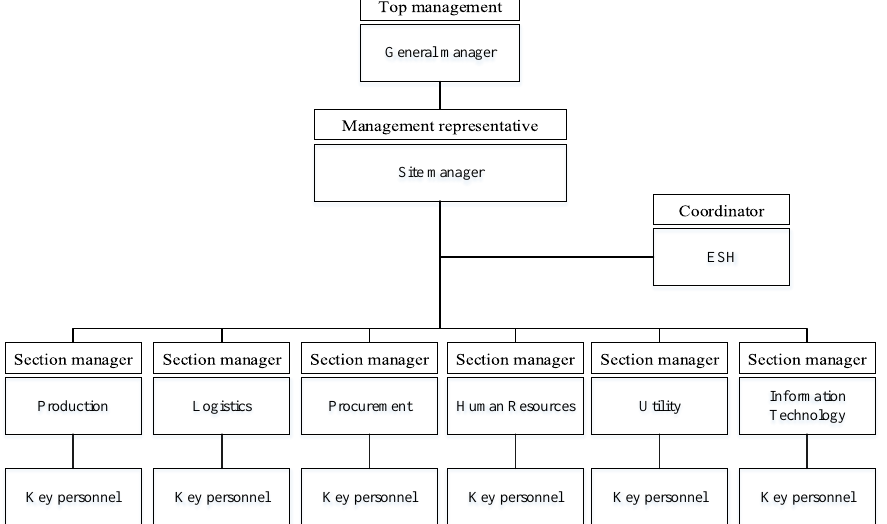
Figure 1. Energy management structure of the factory.